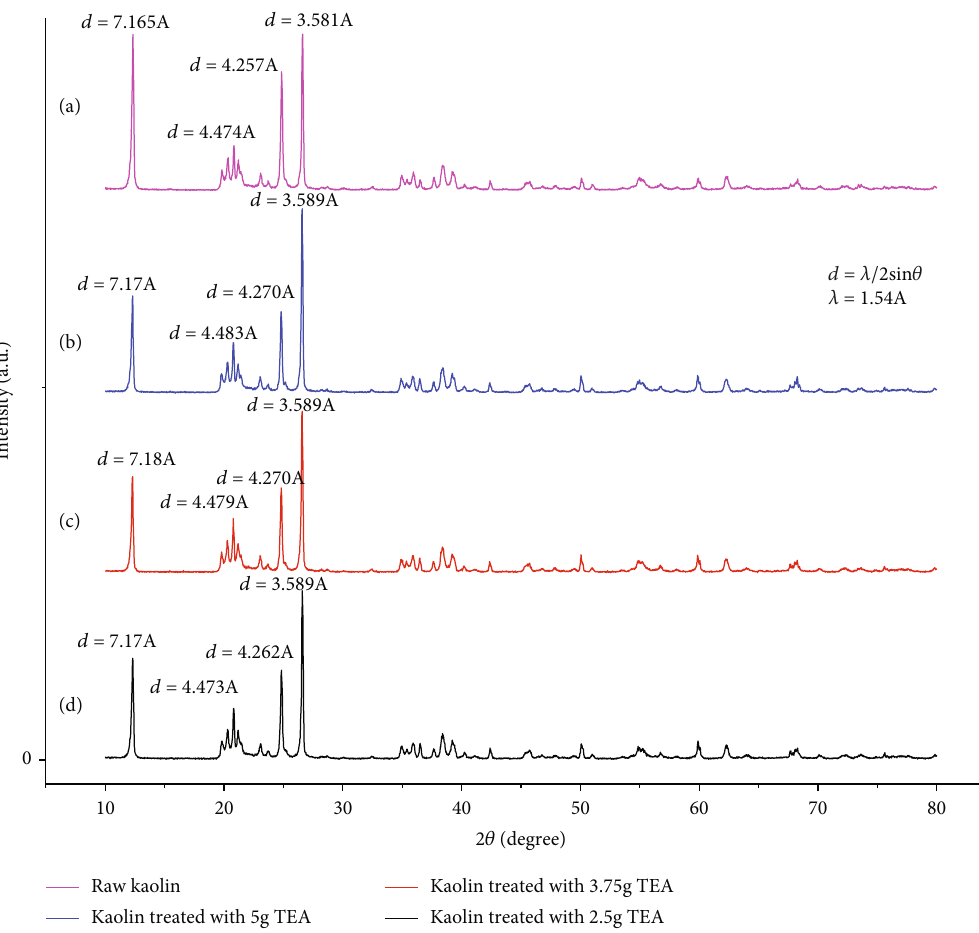
Figure 6: Comparison of interplanar or d-spacing of kaolin clay modi fi ed by (a) kaolin as received, (b) 5g, (c) 3.75g, and (d) 2.5 g of TEA modi fi er based on XRD analysis.